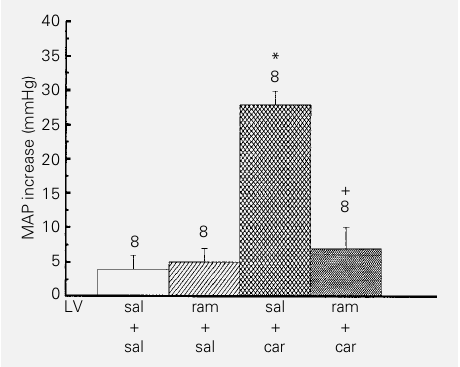
Figure 2 - Effect of ramipril (ram) injection into the lateral ventricle (LV) on the mean arterial blood pressure (MAP) of rats before LV injection of carbachol (car) or isotonic saline (sal). Results are reported as mean – SEM. The number of rats is given at the top of each column. *P<0.05 compared to sal + sal. + P<0.05 compared to sal + car (Dunnett t -test).